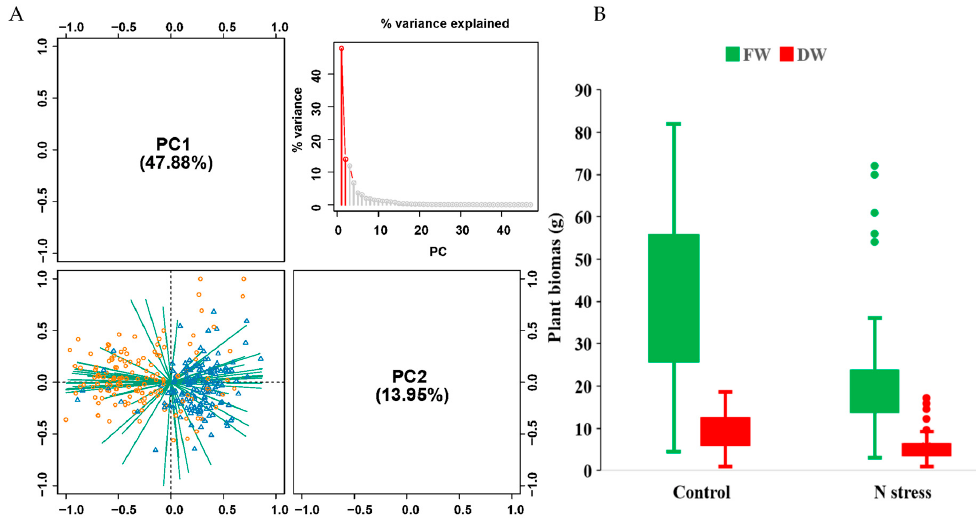
Figure 3. Scatter plots showing the results of principal component analysis (PCA) and novel i- trait selection. ( A ) The percentage of total phenotypic variance explained by the top two principal components estimated from control+ N stress. The component scores are shown in points, treatments are shown as colors (orange color code for control and blue color code for Nstress treatment) and loading vectors are represented as projected lines. ( B ) Box plot showing the distribution of fresh and dry weight data points across the